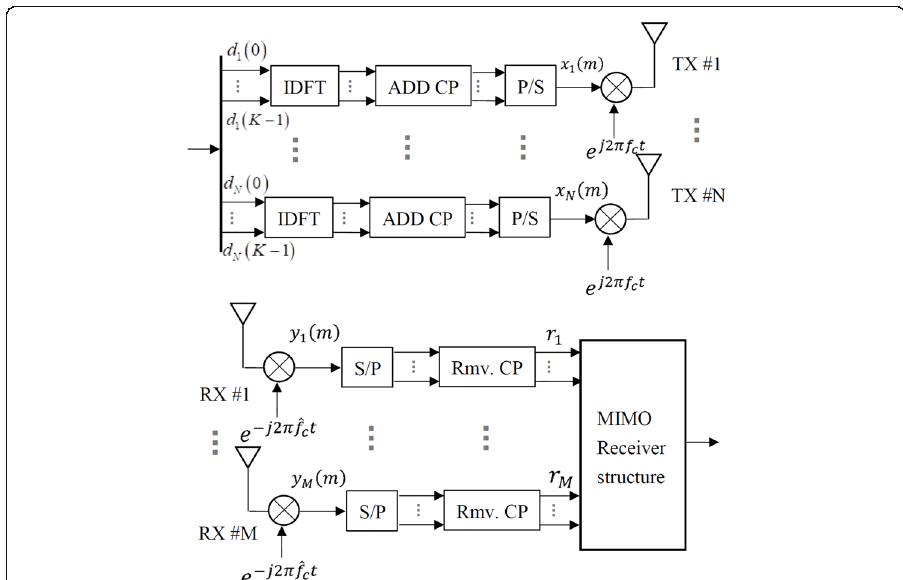
Fig. 1 Transmitter and receiver structure of N × M MIMO-OFDM system